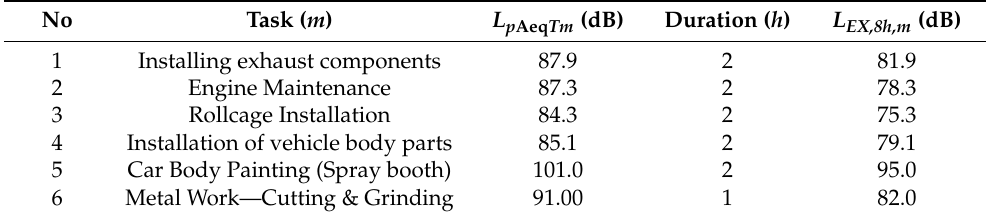
Table 4. A-weighted equivalent continuous sound pressure level and noise contribution from task m to the daily A-weighted noise exposure level results for work activities in the automotive maintenance